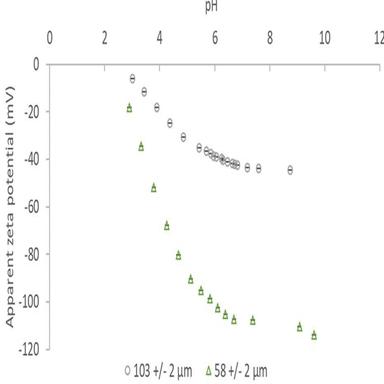
Apparent zeta potential of the RC unmodified membrane (determined from the Smoluchowski equation) versus pH for two gap heights (hch = 103 ± 2 µm and 58 ± 2 µm); Solution: 0.001 M KCl.